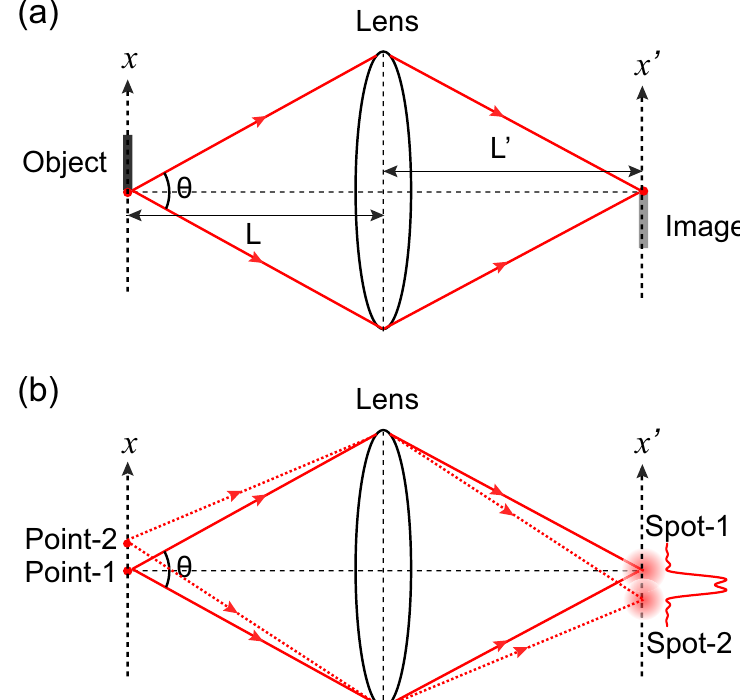
Figure 1. ( a ) Schematic of lens-assisted imaging system. The divergence of light wave originating from a point of the object is reversed by the lens, converging to a point on the image plane; ( b ) The point-to-point correlation between the object and the image plane is not ideal. The image spot is of finite size that is determined by the wavelength of the light wave λ and the numerical aperture of the imaging lens n sin ( θ /2 ) (refractive index n = 1 for